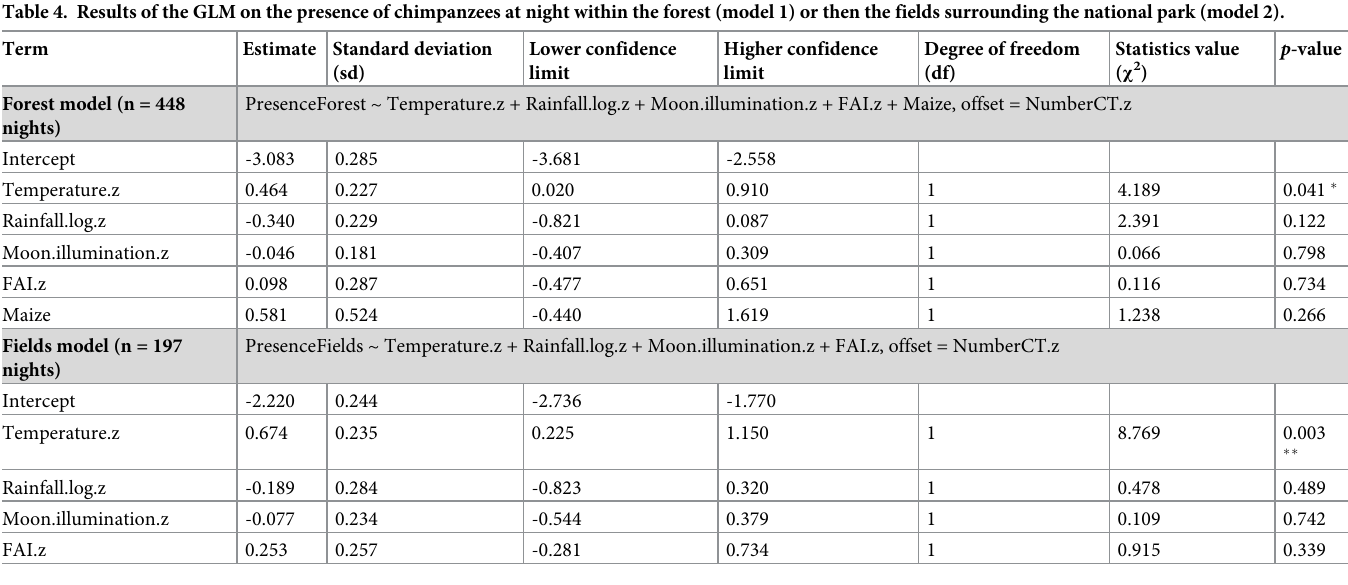
Table 4. Results of the GLM on the presence of chimpanzees at night within the forest (model 1) or then the fields surrounding the national park (model 2). Term Estimate Standard deviation